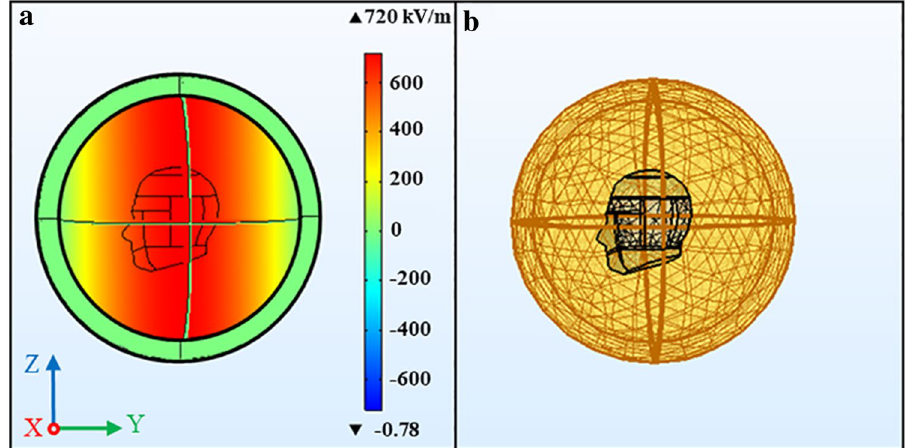
Figure 2. The simulation scene and model meshing. ( a ) Coordinate system definition and the incident wave, ( b ) simulation region and FEM meshing. We used COMSOL Multiphysics software, version 5.4 (https:// www. comsol. com/ comsol- multi physi cs) for simulation